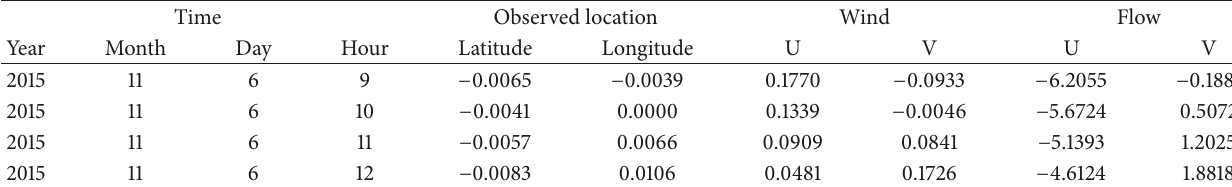
Table 3: Attributes of the transformed training data (examples).